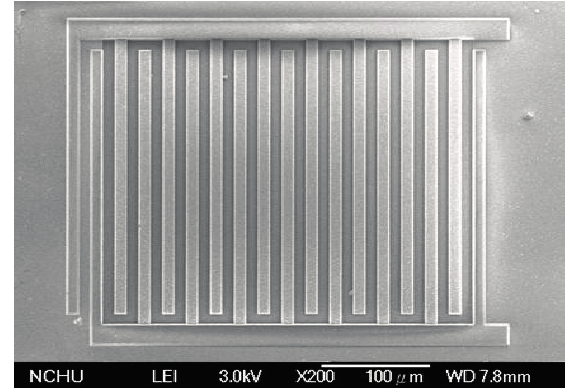
Figure 8. SEM image of the acetone sensor after the wet etching.